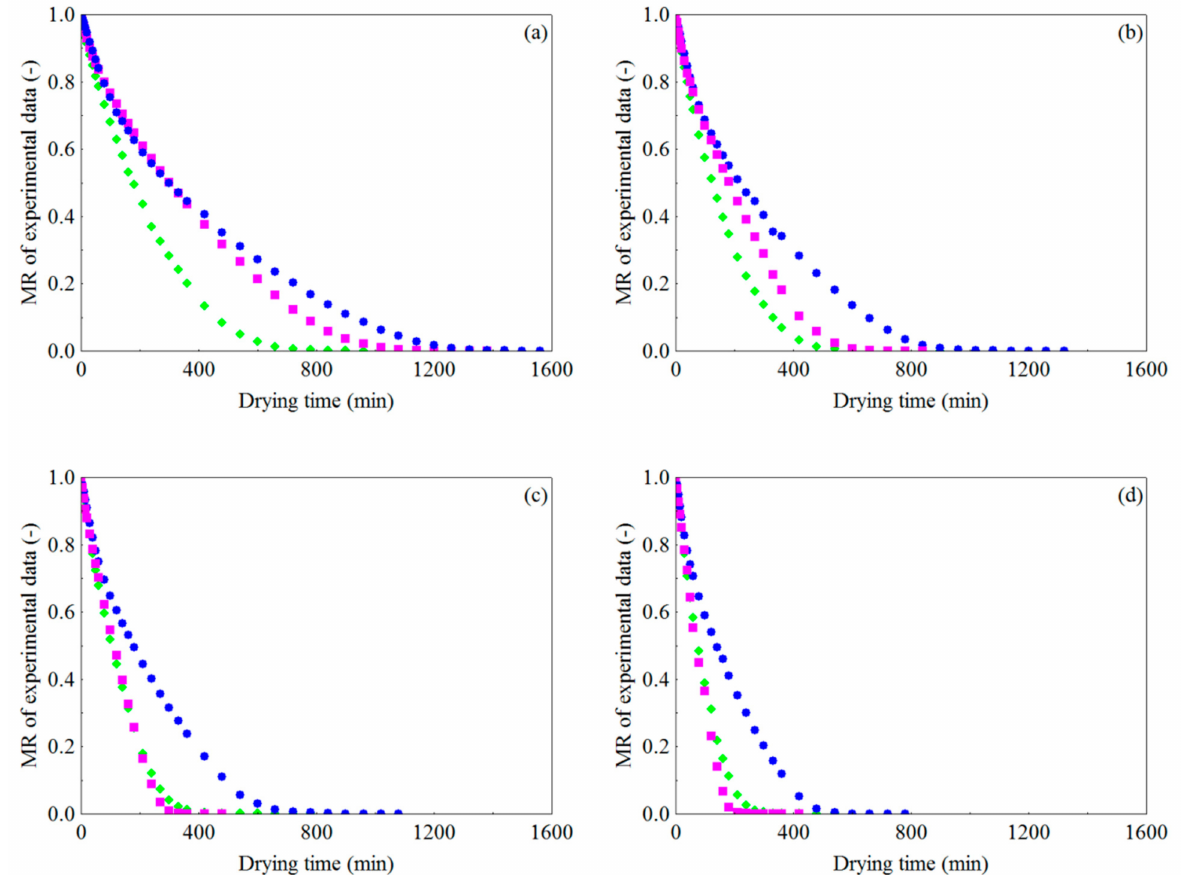
Figure 3. Dimensionless moisture content vs. drying time in different pretreatments for air temperatures of ( a ) 50 ◦ C, ( b ) 60 ◦ C, ( c ) 70 ◦ C and ( d ) 80 ◦ C: ( ) whole residue, ( ) crushed residue and ( ) residue in the form of